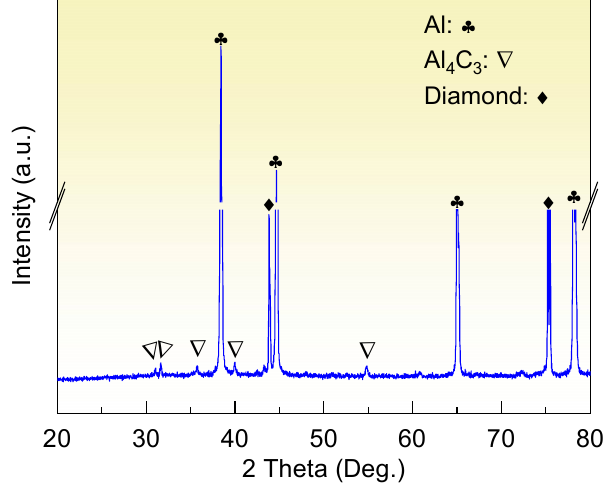
Figure 3. XRD pattern of the diamond/Al composite.